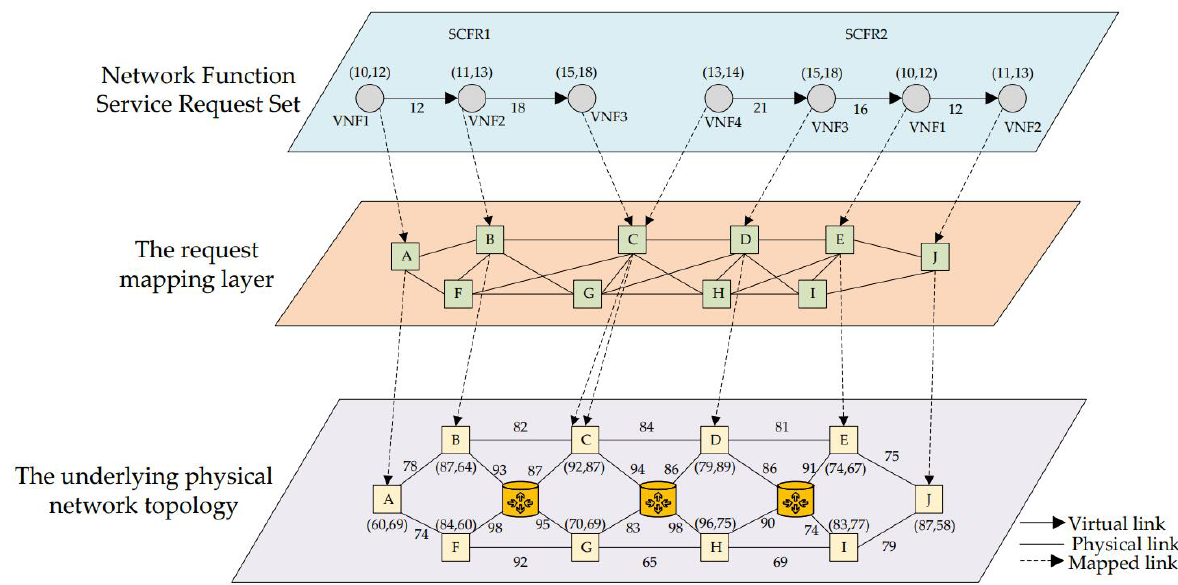
Figure 1. The improved SFC mapping